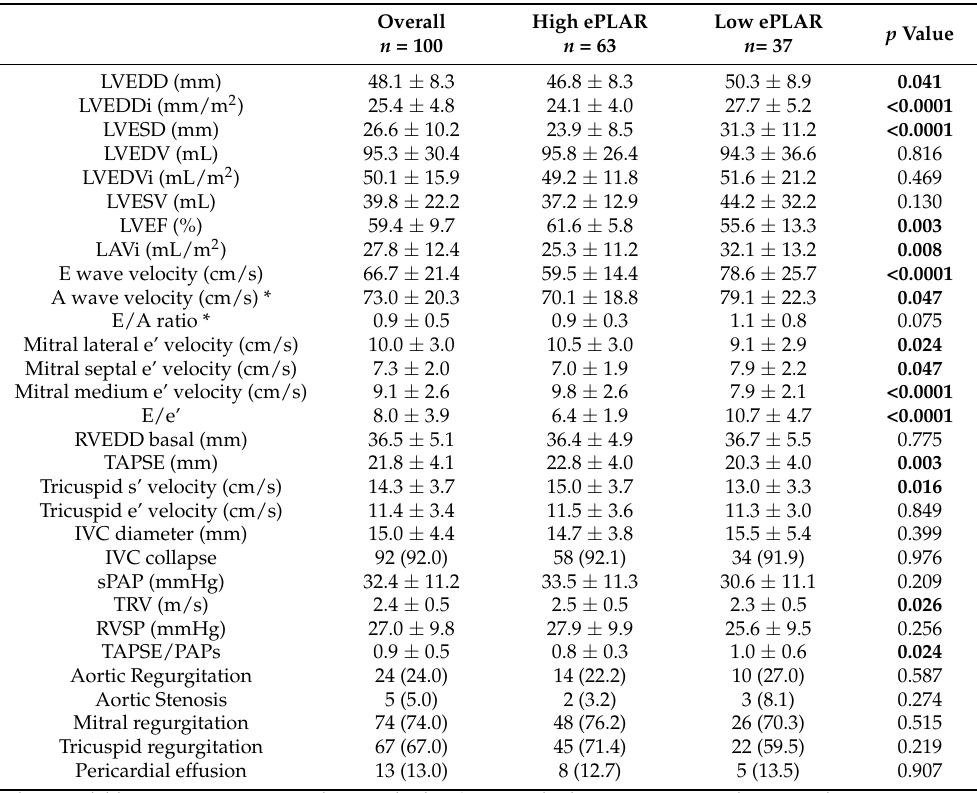
Table 2. Echocardiographic parameters of patients with COVID-19, in the overall population and according to ePLAR values at baseline.